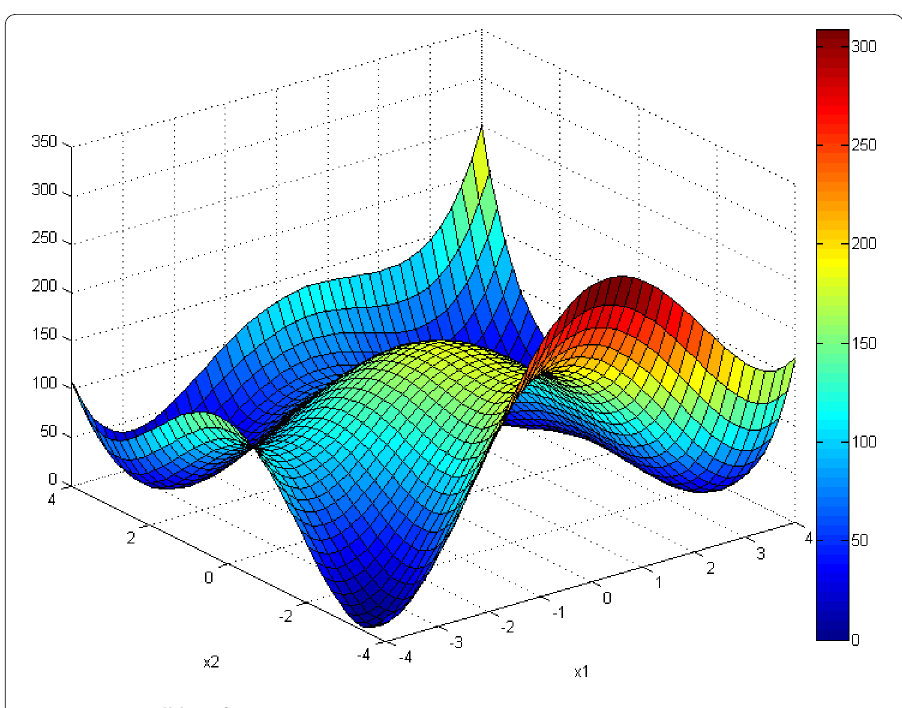
Figure 1 Himmelblau’s function.